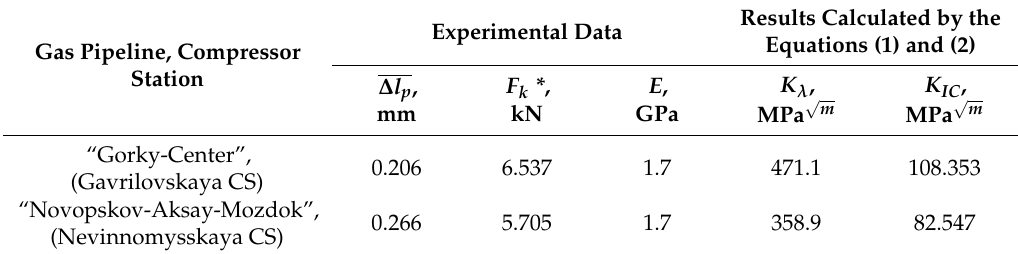
Table 2. Cracking resistance parameters K λ and K IC for the steel after a long-term Table 3. Cracking resistance parameters К λ and К I С for the steel after a long ‐ term operation.